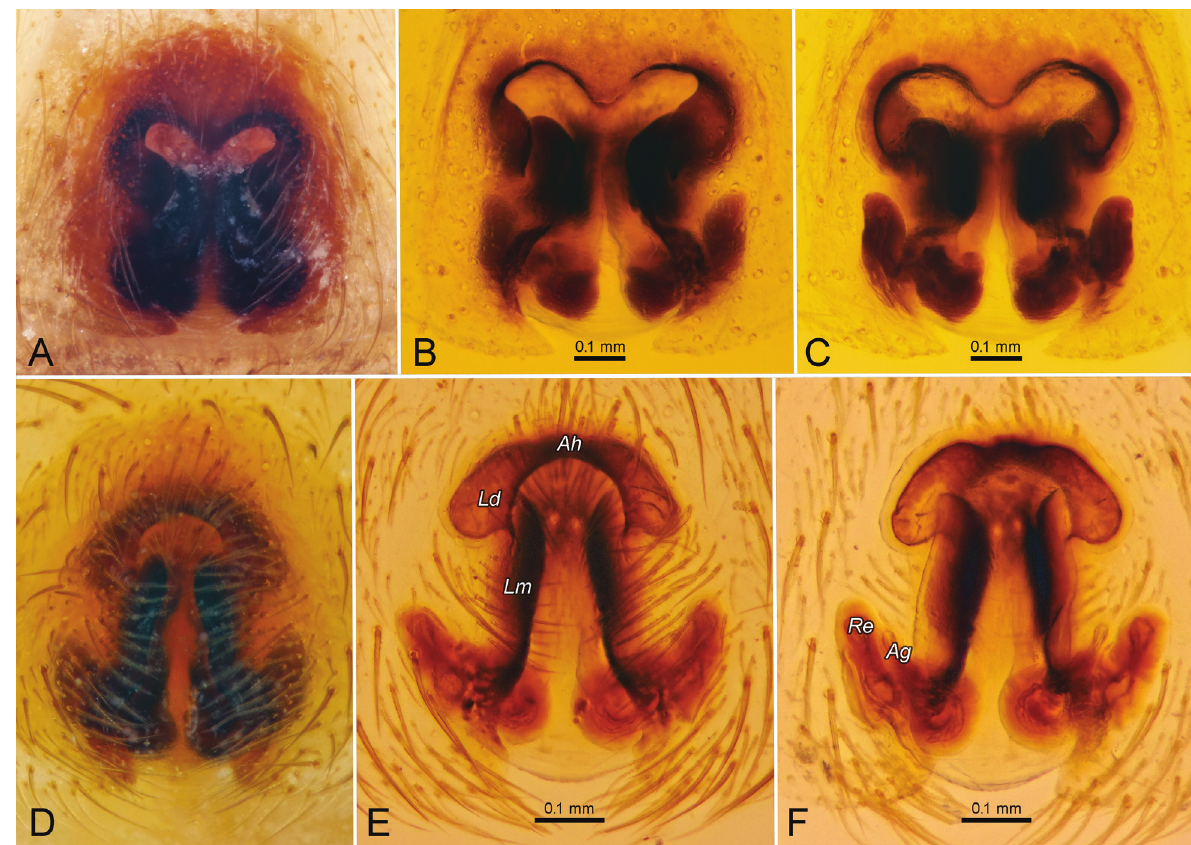
Figure 5. Epigynes of Pterotricha dalmasi Fage, 1929 ( A–C ) and Pterotricha kovblyuki Zamani & Marusik, 2018 ( D–F ). A, D. intact epigyne, ventral view; B, E. macerated epigyne, ventral view; C, F. vulva, dorsal view. Abbreviations: Ag – accessorial